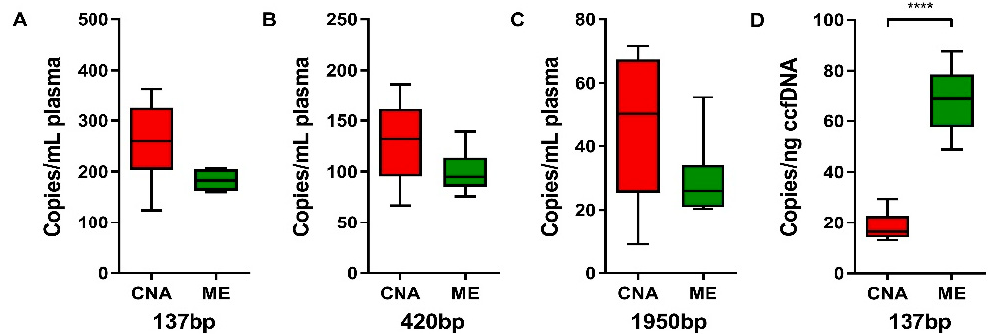
Figure 5. Comparison of β -actin fragment sizes among the CNA and ME extraction methods in DLA samples. Boxplots illustrating the number of copies per mL of plasma for the 137 ( A ), 420 ( B ), and 1950 bp ( C ) fragment sizes, as well as the 137 bp copies per ng of ccfDNA ( D ) as measured with the one-tube 3-sized β -actin ddPCR assay. Horizontal lines represent the median, the boxes, and the interquartile range. All median values and interquartile ranges are depicted in Table S3. Generalized linear mixed model, * p < 0.05, *** p < 0.001.